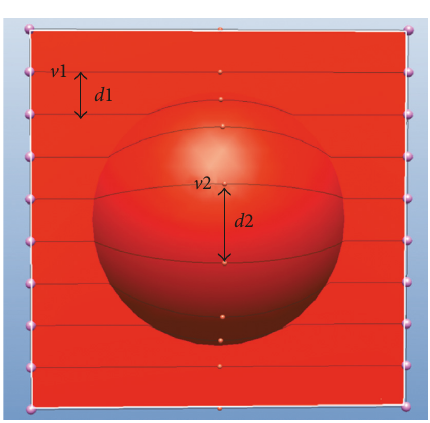
Figure 10: Meaning of character v 1, v 2, d 1, and d